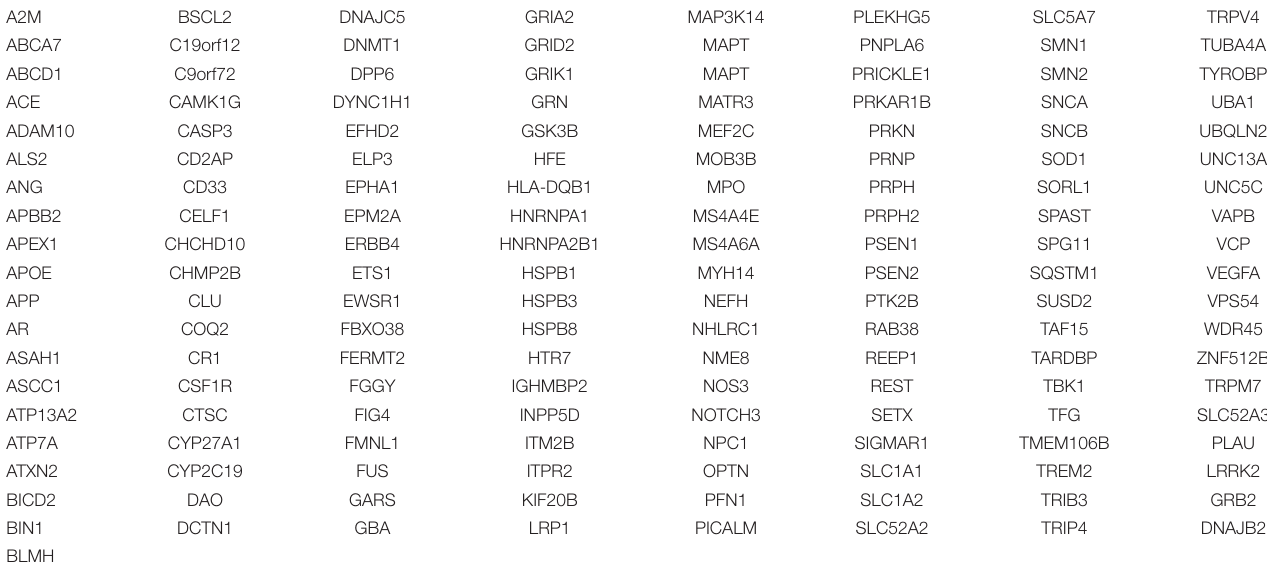
TABLE 1 | Dementia-related causing and susceptible genes.